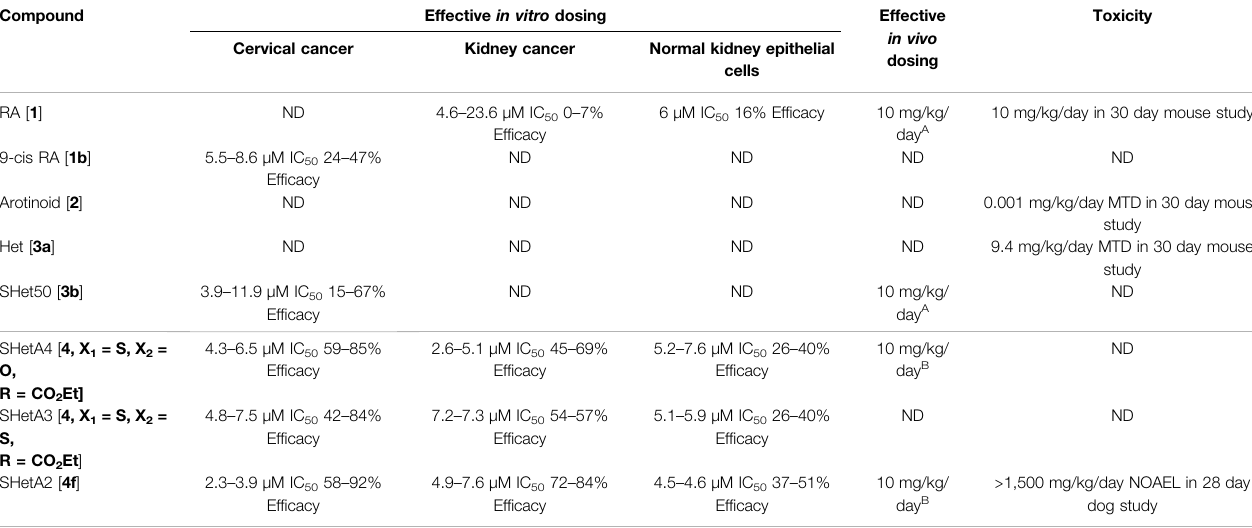
TABLE 1 | Comparison of SHetA2 activities and toxicities with retinoids, Hets and other Flex-Hets. Compound Effective in vitro dosing Effective